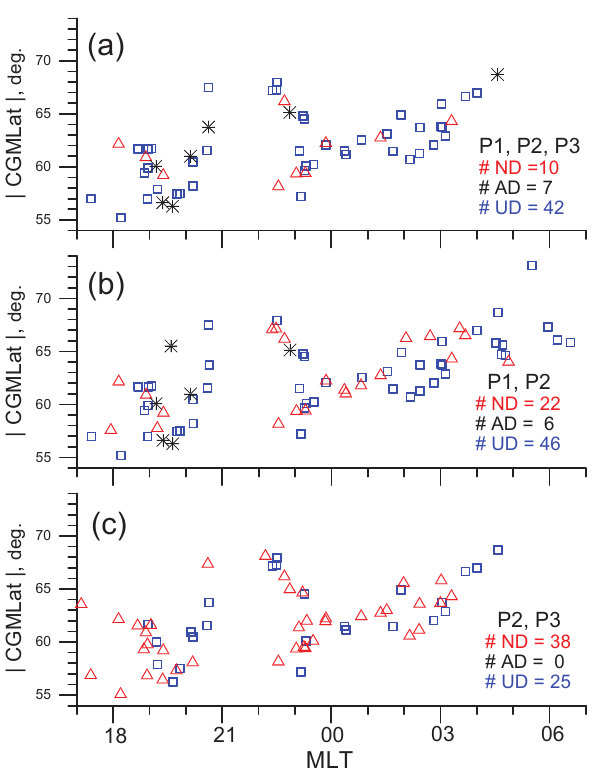
Fig. 5. CGMLat vs. MLT plot of P2 IB positions. Red triangles cor- respond to ND type, black asterisks to AD type and blue squares to UD type. Panels correspond to different dispersion type classifi- cation methods. (a) involving P1, P2, P3 channels, (b) P1 and P2 channels, (c) P1 and P3 channels, see explanation in the text.